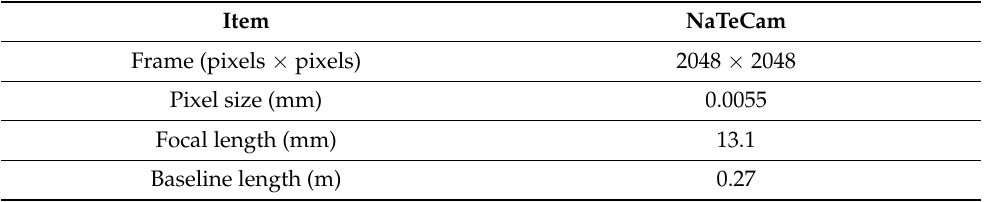
Table 1. Parameters of NaTeCam